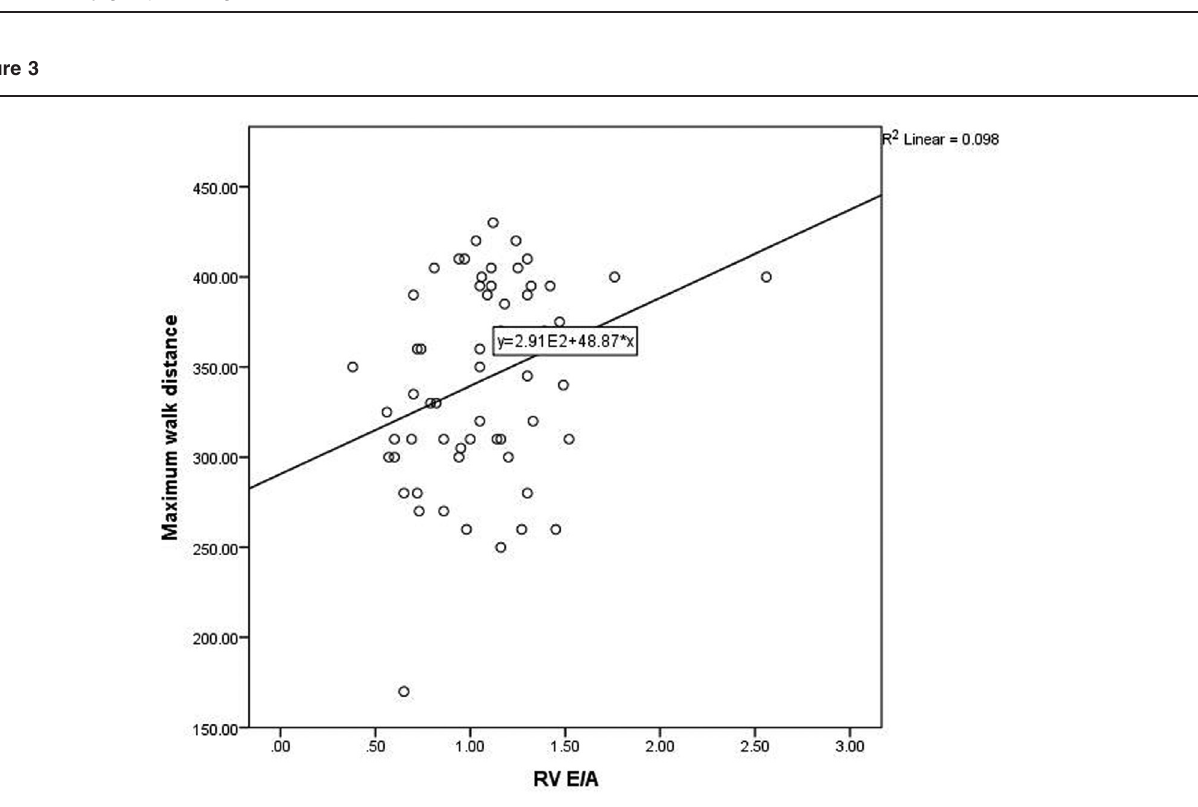
Correlation between 6-min walk distance and right ventricular E/A in the whole study group. A lower 6-min walk distance is associated with lower E/A